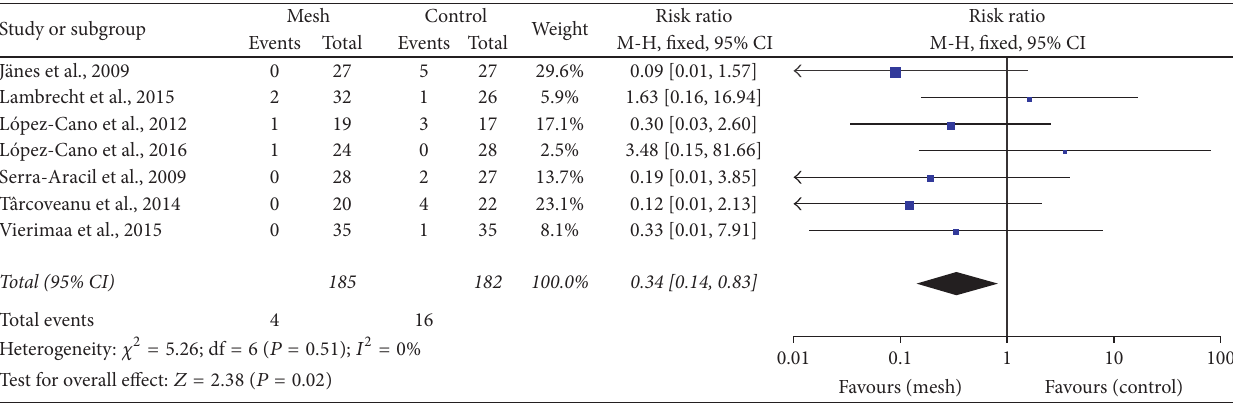
Figure 5: Forest plot for surgical repair for parastomal